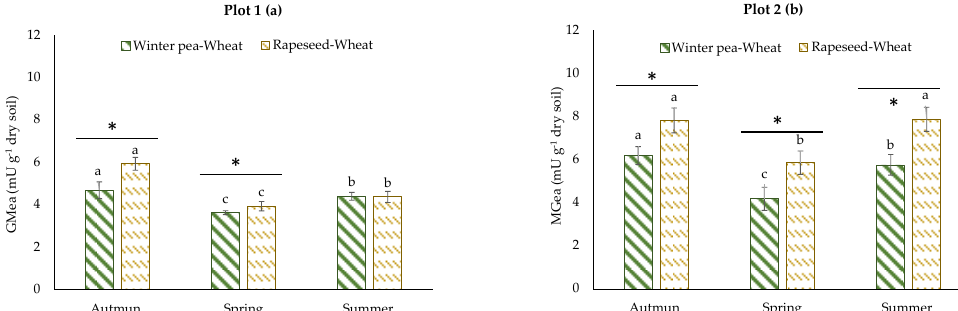
Figure 4. Patterns of the geometric mean of assayed enzymes determined in two crop successions (winter pea–wheat, rapeseed–wheat) at 3 sampling dates in plot 1 ( a ) and plot 2 ( b ). Error bars on data points represent the standard errors of the mean of three replicates (n = 3). Letters indicate statistical significance between the 3 sampling dates and asterisks indicate statistical significance between the two successions (winter pea–wheat vs. rapeseed–wheat) at p < 0.05 according to Tukey’s test.